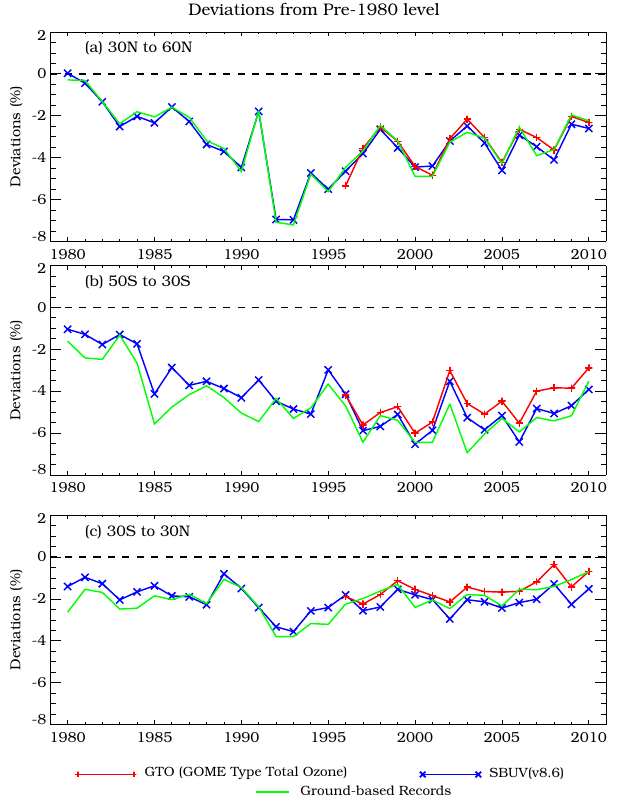
Figure 9. Deviations in annual mean total ozone from pre-1980 lev- els: (a) 30 ◦ N–60 ◦ N, (b) 50 ◦ S–30 ◦ S, and (c) 30 ◦ S–30 ◦ N.